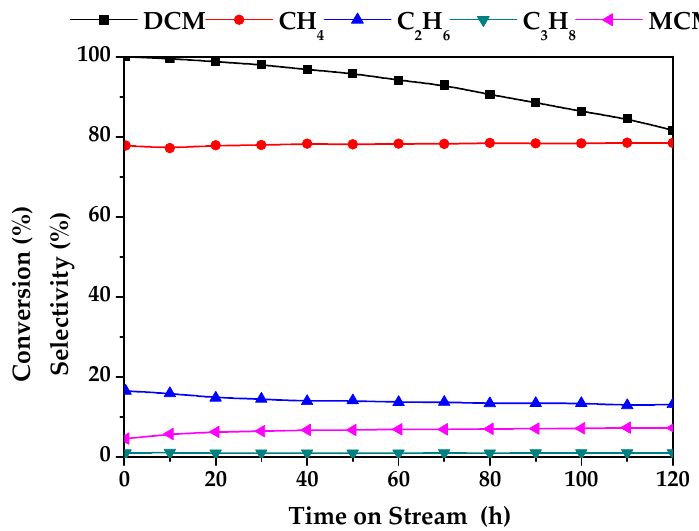
Figure 1. Evolution of dichloromethane (DCM) conversion and selectivity to reaction products upon time on stream in the hydrodechlorination (HDC) of DCM during 120 h ( τ = 1.73 kg h mol − 1 , T reaction = 250 ◦ C).